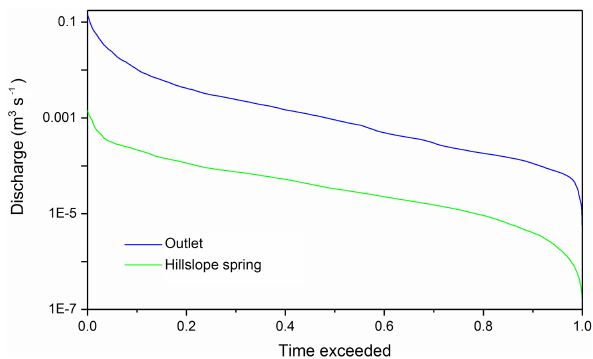
Figure 2. Flow duration curve at outlet and hillslope spring (HS) (28 July 2016–30 October